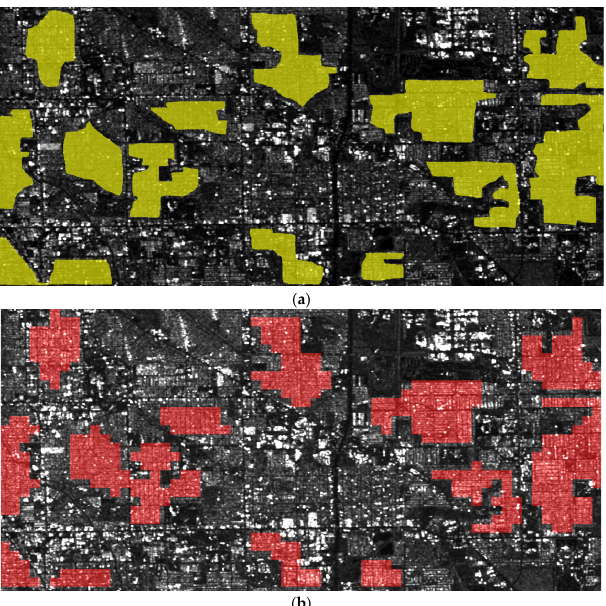
Figure 5. The residential hyper-pixels of manual extraction in Houston scene. ( a ) The manual- extracted hyper-pixels, as shown in the irregular yellow areas. ( b ) The slices of the hyper-pixel set. We selected the 14 hyper-pixel targets as a fixed set for extracting the radiometric data from the scene to analyze the radiometric stability performance. For the irregular area covered by the extracted hyper-pixel set, first of all, the selected area was sliced, with a processing approach of 20 × 20 pixel slicing. When the slicing coverage overlapped with more than half of the hyper-pixel target pixels, the slice can WAS set as the target area; the area marked in red in Figure 5b represents the final slices of the hyper-pixel set. Next, according to Equation (2), the median radiation value of the slices was calculated, after which the mean value of each slice was calculated as the radiation datum of all the hyper- pixels. The radiation-data values of the scene are shown in the time domain in Figure 6.